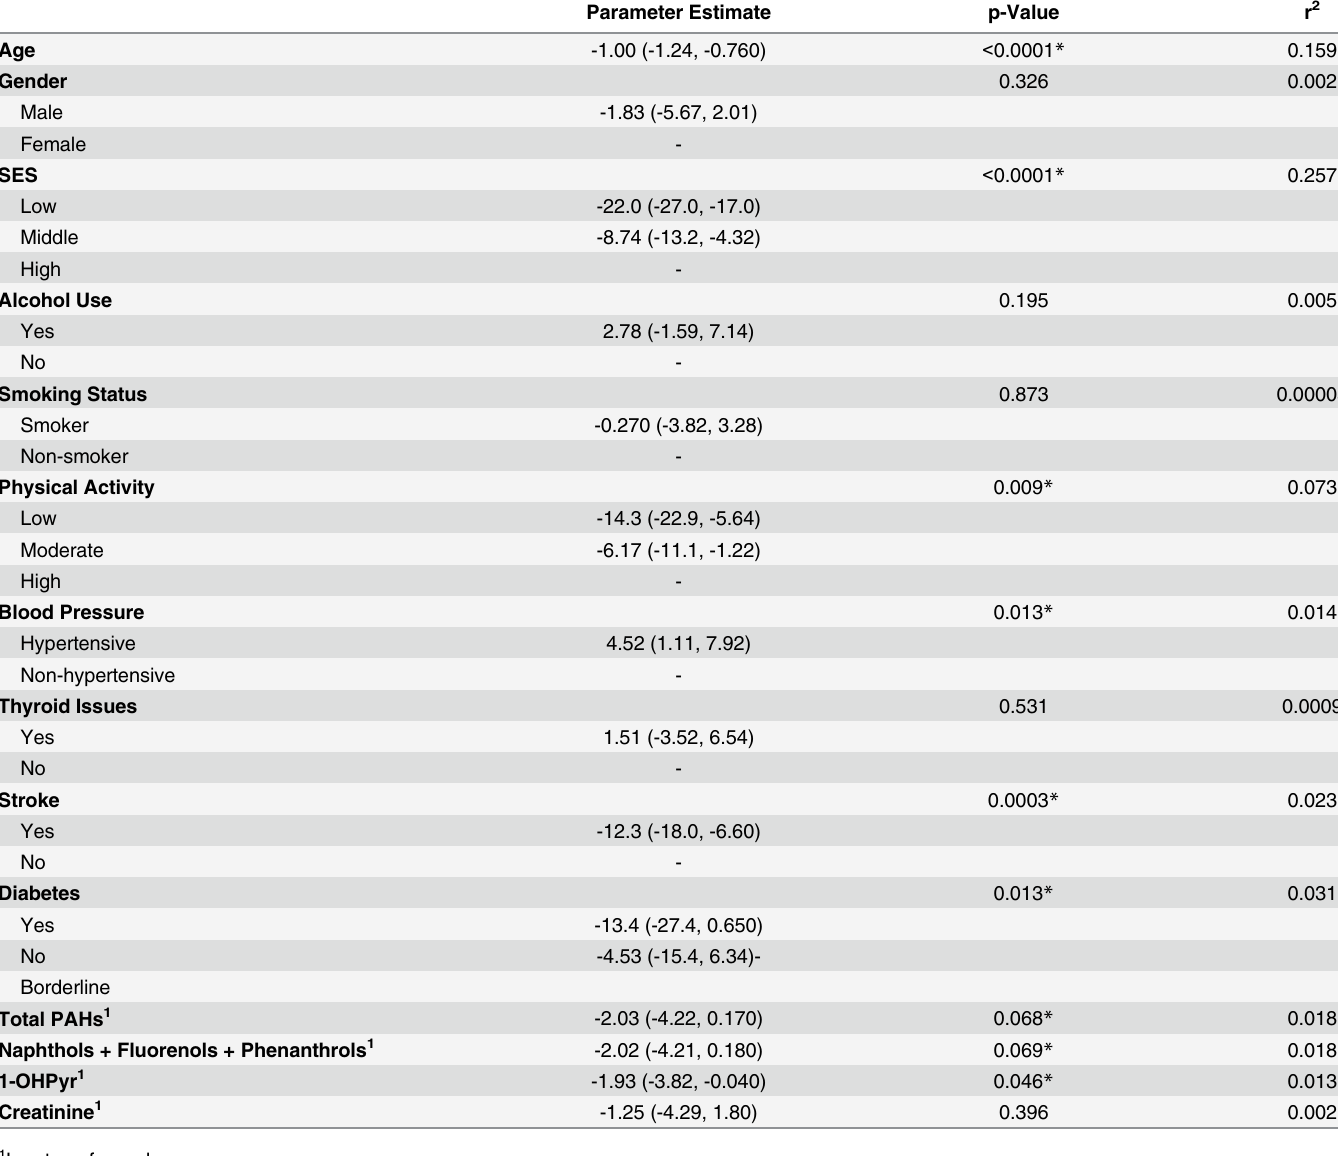
Table 4. Parameter Estimates (95% CIs) and Coefficients of Determination of Digit Symbol Substitution Test Scores by All Covariates from Univar- iate